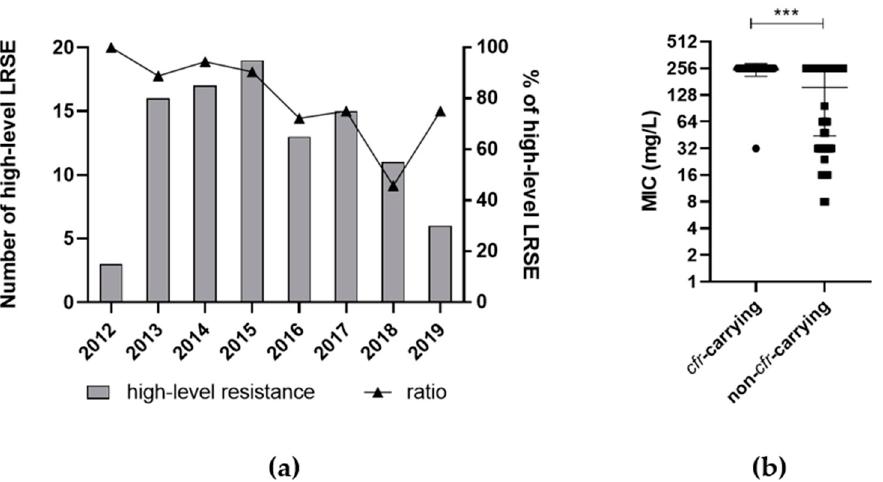
Figure 2. Phenotypically high linezolid resistance levels and minimal inhibitory concentrations (MIC). ( a ) The total amount of high-level linezolid-resistant S. epidermidis (LRSE) as well as the percentage of high-level LRSE decreased over the years. ( b ) Presence of cfr expressed phenotypically higher MIC levels. MIC break points of cfr -carrying and non- cfr -carrying isolates were compared by Fisher’s exact test (*** p < 0.001).